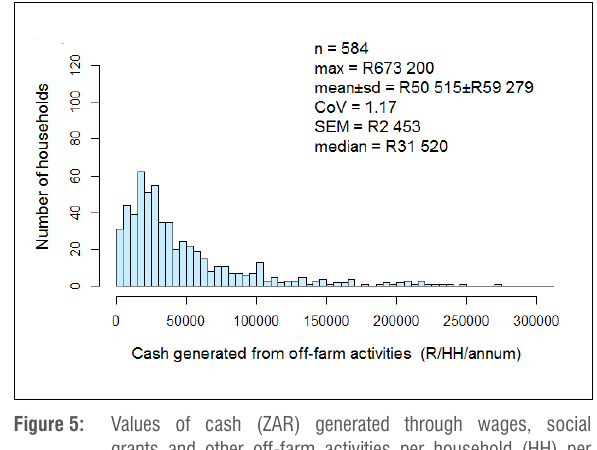
Figure 5: Values of cash (ZAR) generated through wages, social grants and other off-farm activities per household (HH) per annum across a sample size of 590 households in 2010, in Bushbuckridge, South Africa The complete livelihood portfolio